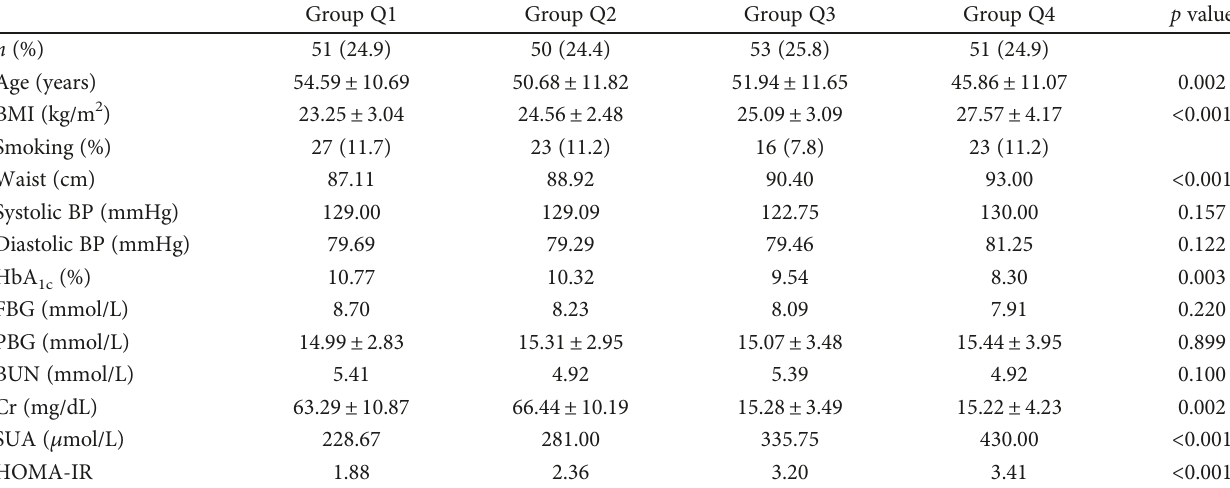
Table 1: Laboratory indices of glucose metabolism and related parameters in the study population disaggregated by quartiles of serum uric acid level.